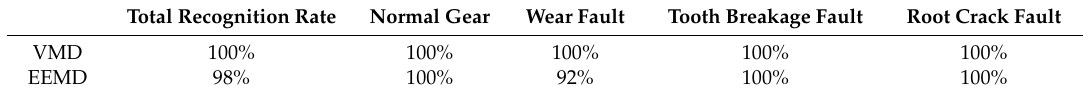
Table 4. Recognition rate of different gear faults.